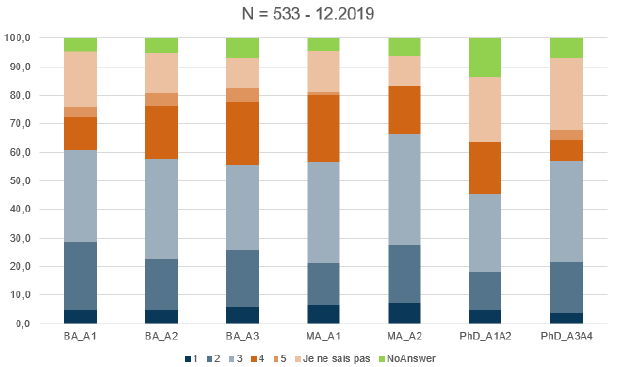
Fig. 1. Answers of the students to the question “Do you feel well prepared for digital skills?” (Survey of 12.2019)